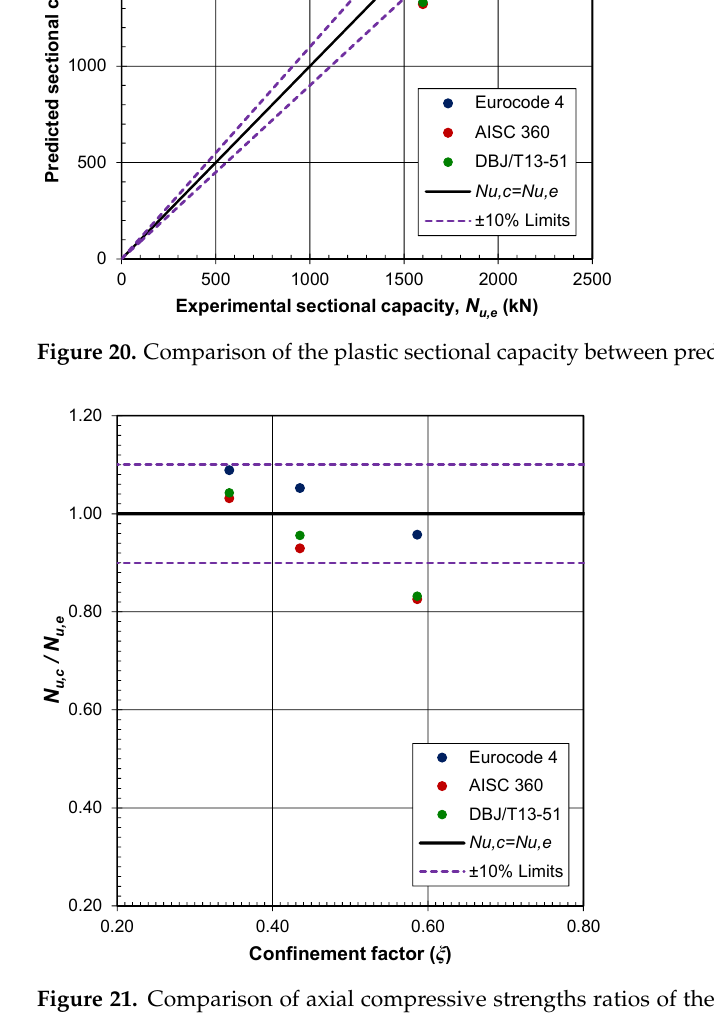
Figure 20. Comparison of the plastic sectional capacity between predicted and test results.